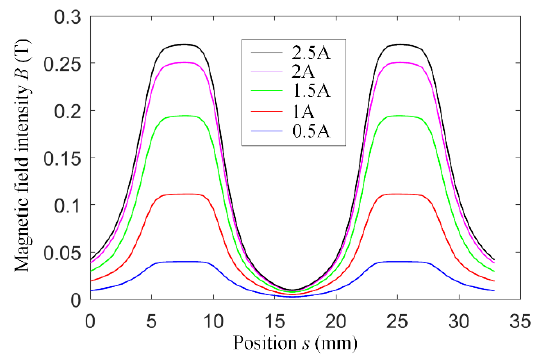
Figure 7. Magnetic induction intensity distribution curve in the annular gap.